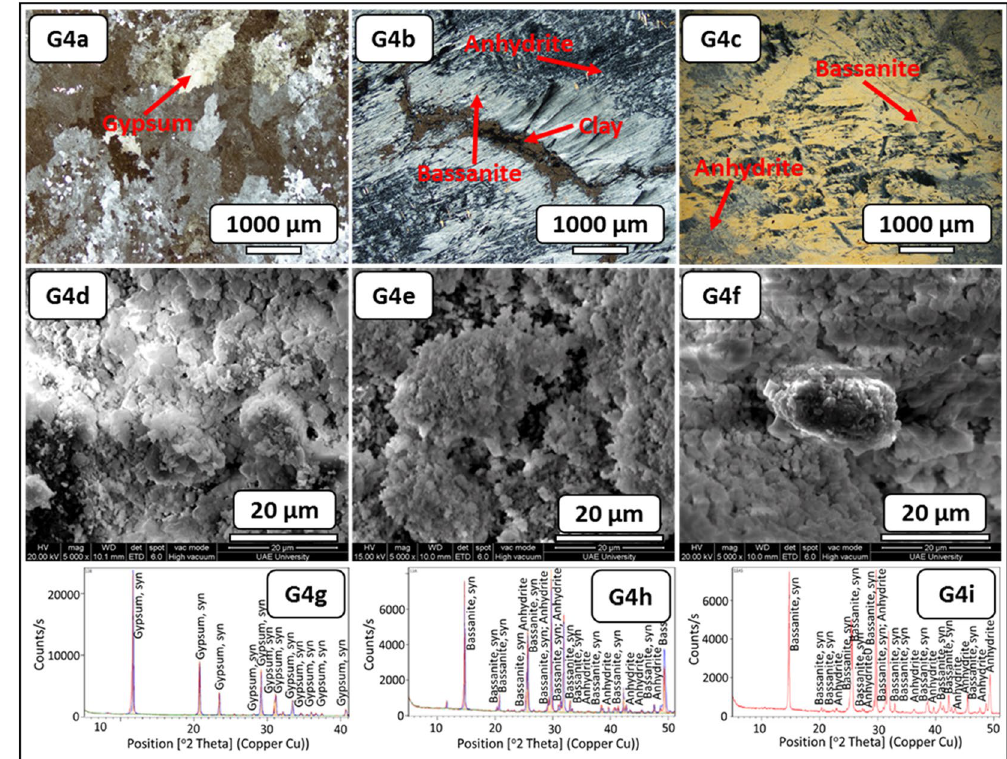
Figure 10. Microscopic description, SEM and XRD of an evaporitic rock Group 4 (fresh sample, after slaking with distilled water and groundwater respectively). G4a–G4c represents thin section images under cross- polarized microscope showing mega-crystalline irregular gypsum crystals intergrowth in mosaic crystals before SDI and fibro-radiating bassanite intergrowth with microcrystalline anhydrite rich with clay patches, after SDI test. G4d-G4f. represents SEM images showing gypsum aggregates before SDI with fibrous mixed bassanite and anhydrite crystals and aggregates after SDI test. G4g–G4i represents XRD analyses showing dominant of gypsum before SDI test where after SDI dominance of bassanite-anhydrite.